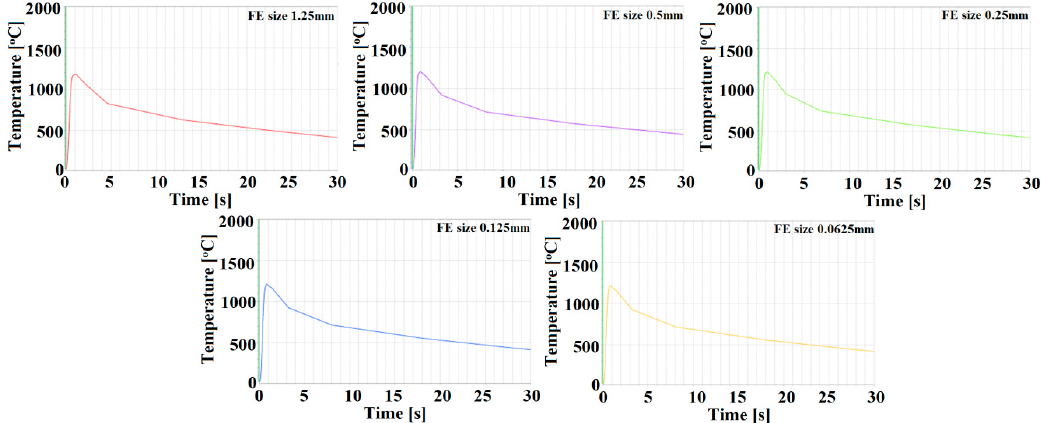
Figure 2. Graphs showing temperature changes for different FE mesh size.